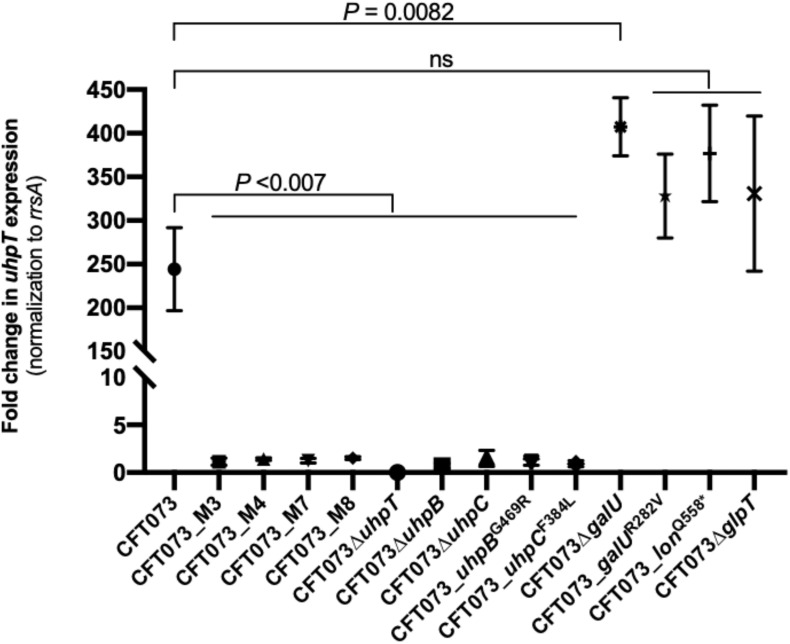
Changes in uhpT expression after induction with 0.2% of G6P in E. coli CFT073 parental strain and its derivative mutants. Transcript levels of uhpT are shown as relative values compared to those of rrsA (16S rRNA) gene. Data plotted correspond to the means and SDs of three biological replicates.